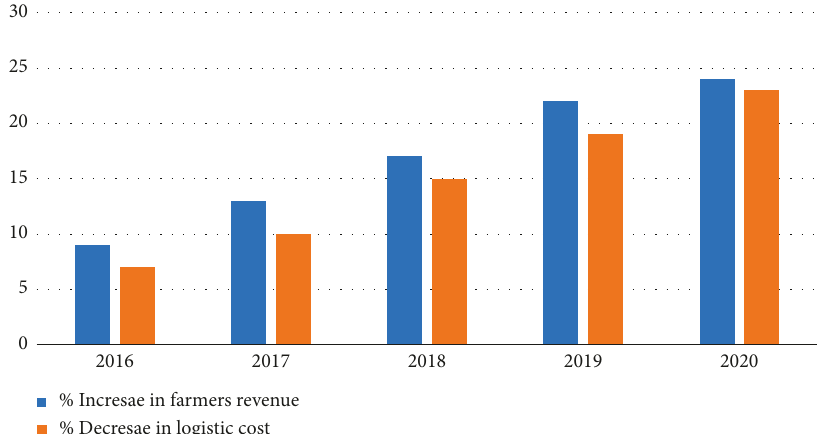
Figure 5: Effect of smart logistic.